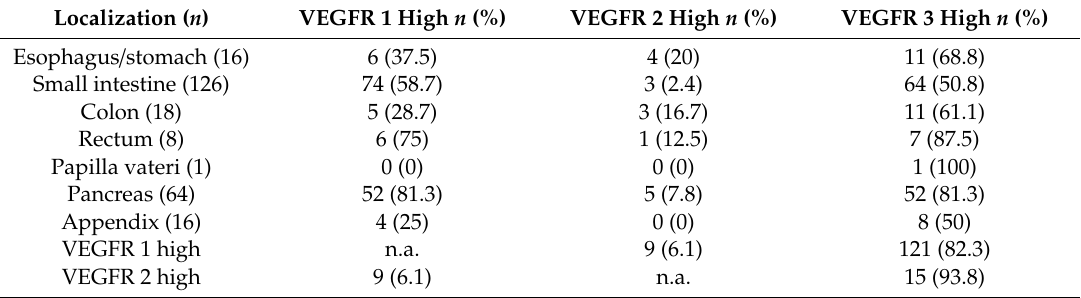
Table 2. Di ff erent expression rates of VEGFR 1-3 regarding the primary tumor localization and the correlation of the expression rates of VEGFR 1-3 (n.a.—not